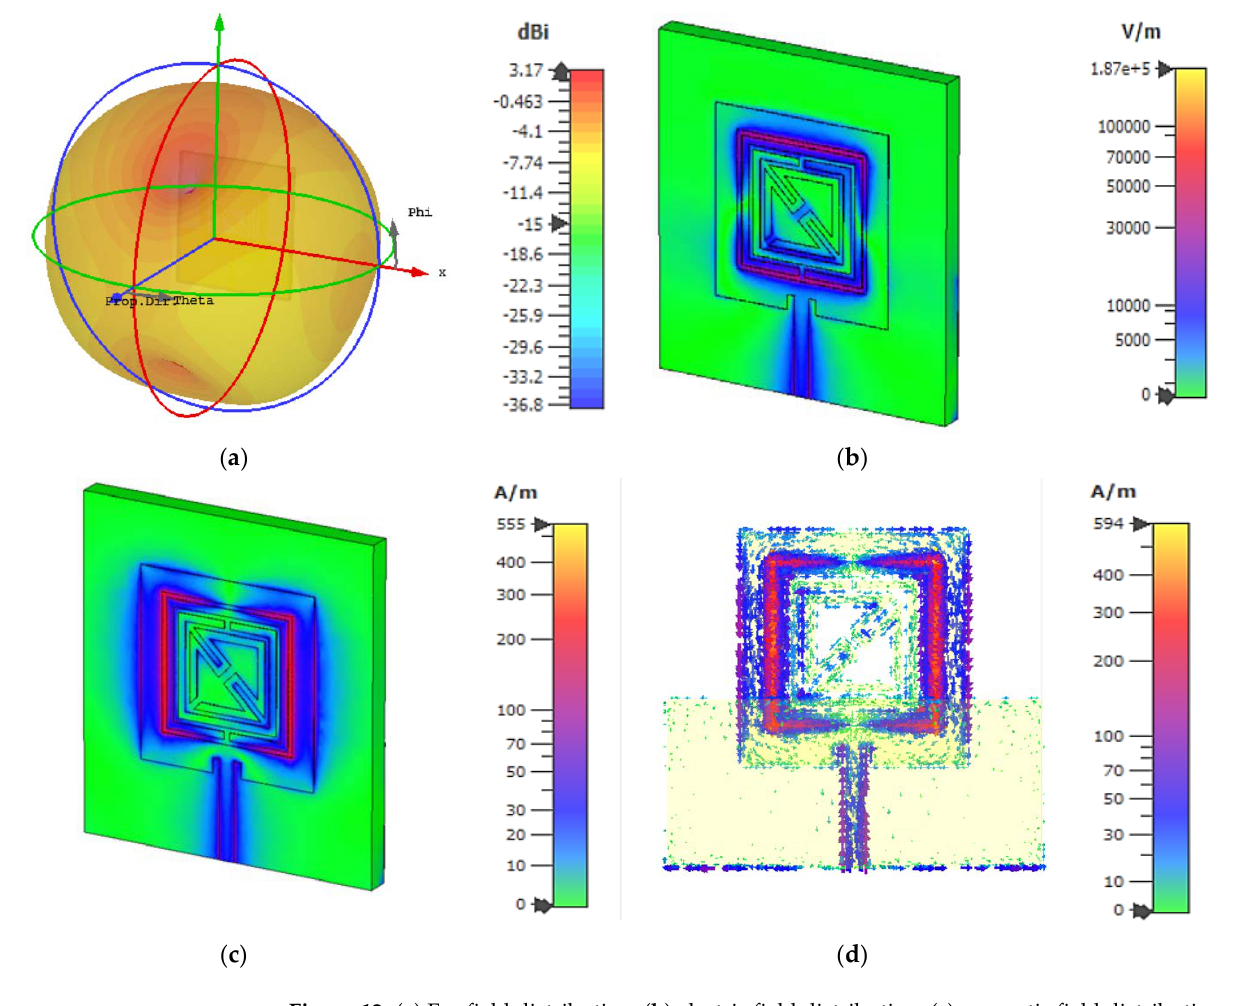
Figure 12. ( a ) Far-field distribution; ( b ) electric field distribution; ( c ) magnetic field distribution; and ( d ) surface current distribution at 6.2 GHz.